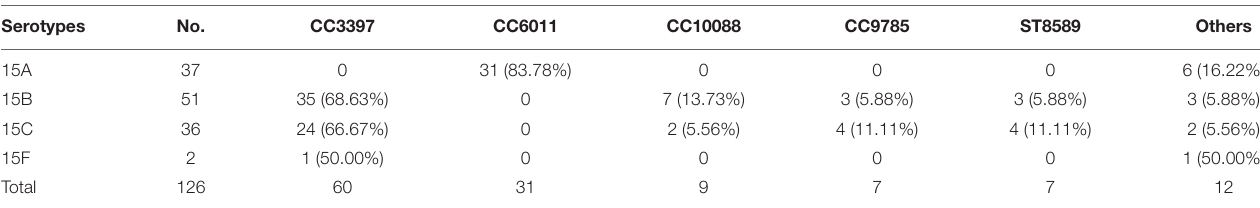
FIGURE 2 | Distribution of sequence types (STs) amongst the clonal complexes of serogroup 15 Streptococcus pneumoniae strains. goeBURST analysis was performed on the multilocus sequence typing data generated from all 126 strains analyzed. STs linked by a line belong to the same cluster. TABLE 3 | CC/ST distribution of serogroup 15 S. pneumoniae by